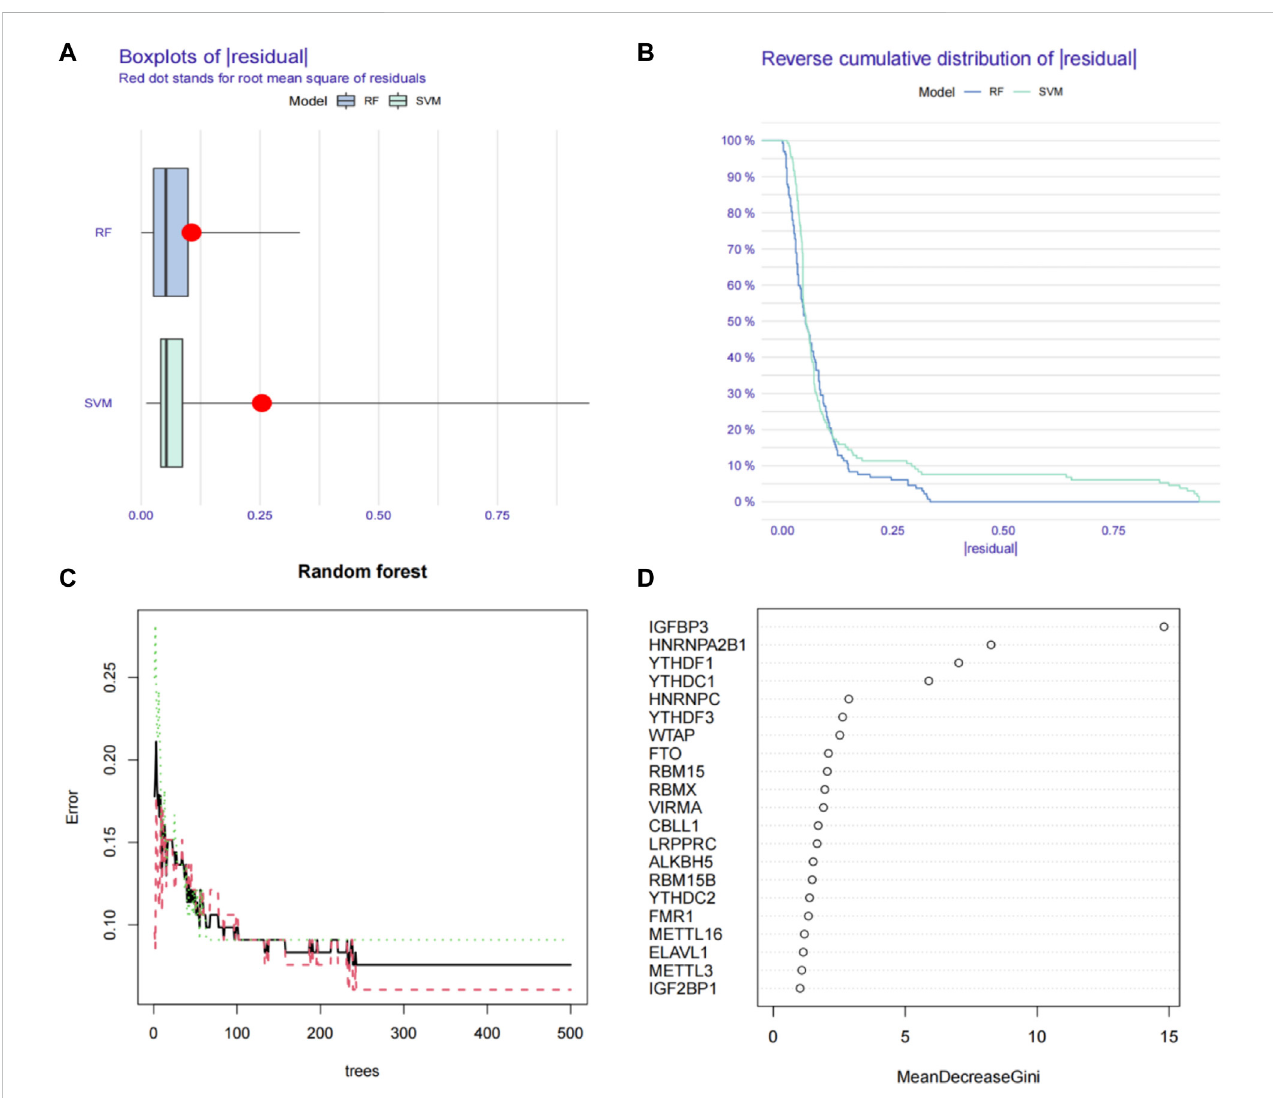
FIGURE 2 Using machine learning to fi nd ESCC-related m6A regulators in our RNA-seq data. (A) Boxplots of residual values of RF (Random Forest) and SVM (Support Vector Machine) models. Red dot represents the mean residual value. (B) Cumulative residual distribution plots of RF (Random Forest) and SVM (Support Vector Machine) models. (C) The error value of therandom forest. The red line represents theerror of the ESCC group, the green line represents the error of the Normal group, and the black line represents the total sample error. The minimum error point of the three-group cross-validation is 0.076, corresponding to 233 optimal random forest trees. (D) Mean Decrease Gini score of 21 differentially expressed m6A regulators extracted from RNA-seq data. RF, Random Forest; SVM, Support Vector Machine; m6A,